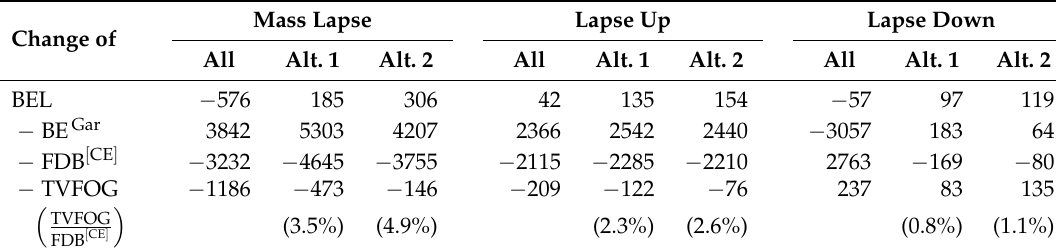
Table 9. Change of BEL ( ∆ BEL ( stress ) ) and its components (in A